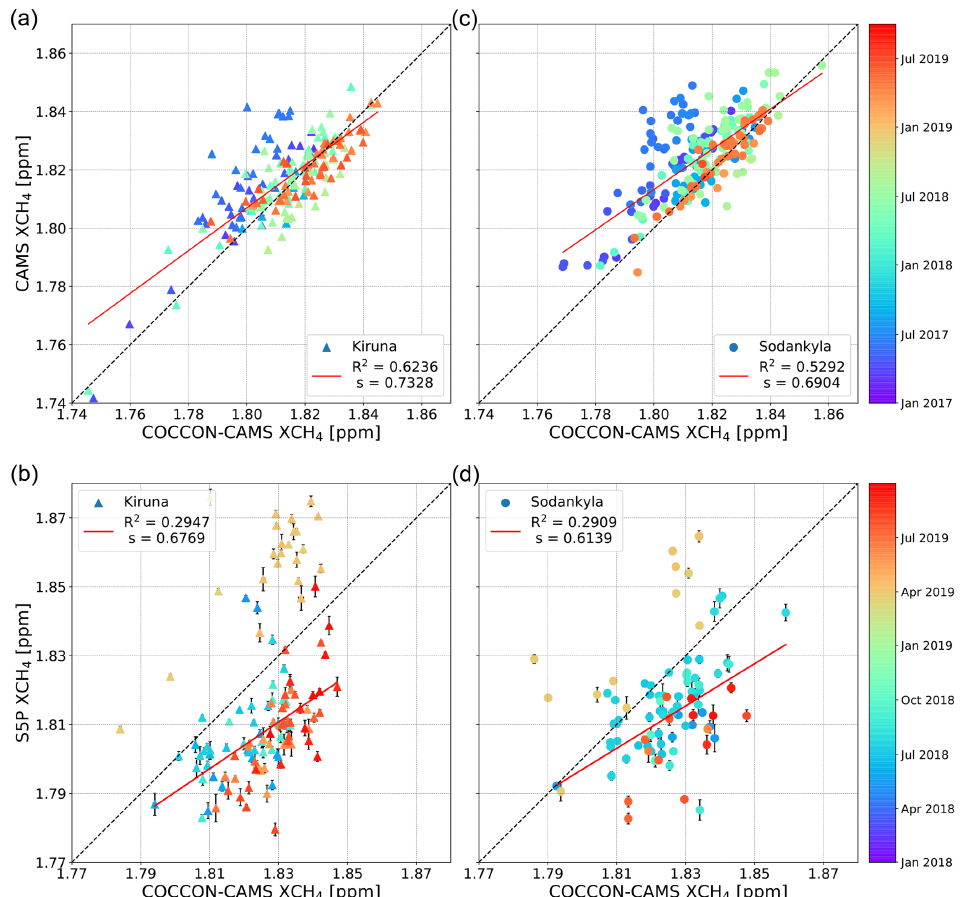
Figure 8. XCH 4 comparison between CAMS (a, c) or S5P (b, d) and COCCON-CAMS in Kiruna (a, b) and Sodankylä (c, d) . Every point represents coincident measurements between two datasets. The annotations follow those in Fig. 5. It is noted that the fitting line derived from the data exclude March and April 2019, and the color bar starts from 2018 rather than 2017 to distinguish the data